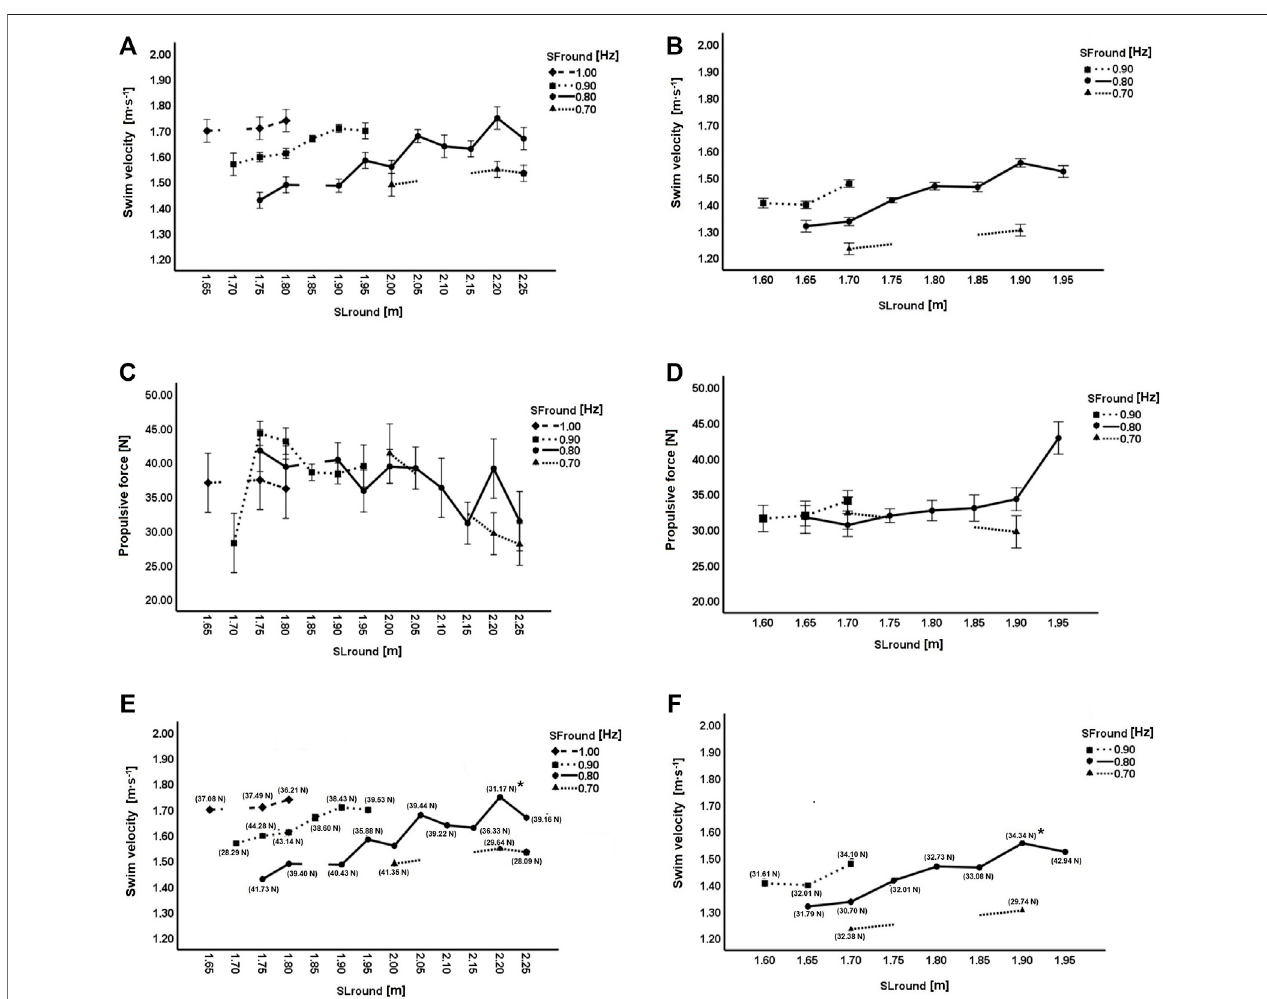
FIGURE 1 | Swimming velocity rounded by SF and SL: Panel (A) males; Panel (B) females. Propulsion rounded by SF and SL: Panel (C) males; Panel (D) females. Swim velocity rounded by SF and SL, with correspondent propulsion (F mean_stroke cycle ) in each SL – SF combination: Panel (E) males; Panel (F) females. * - Panel (E) : highest swimming velocity achieved by male swimmers (1.75 m s − 1 ); Panel (F) : highest swimming velocity achieved by female swimmers (1.56 m s − 1 ). Error bars represent one standard deviation.